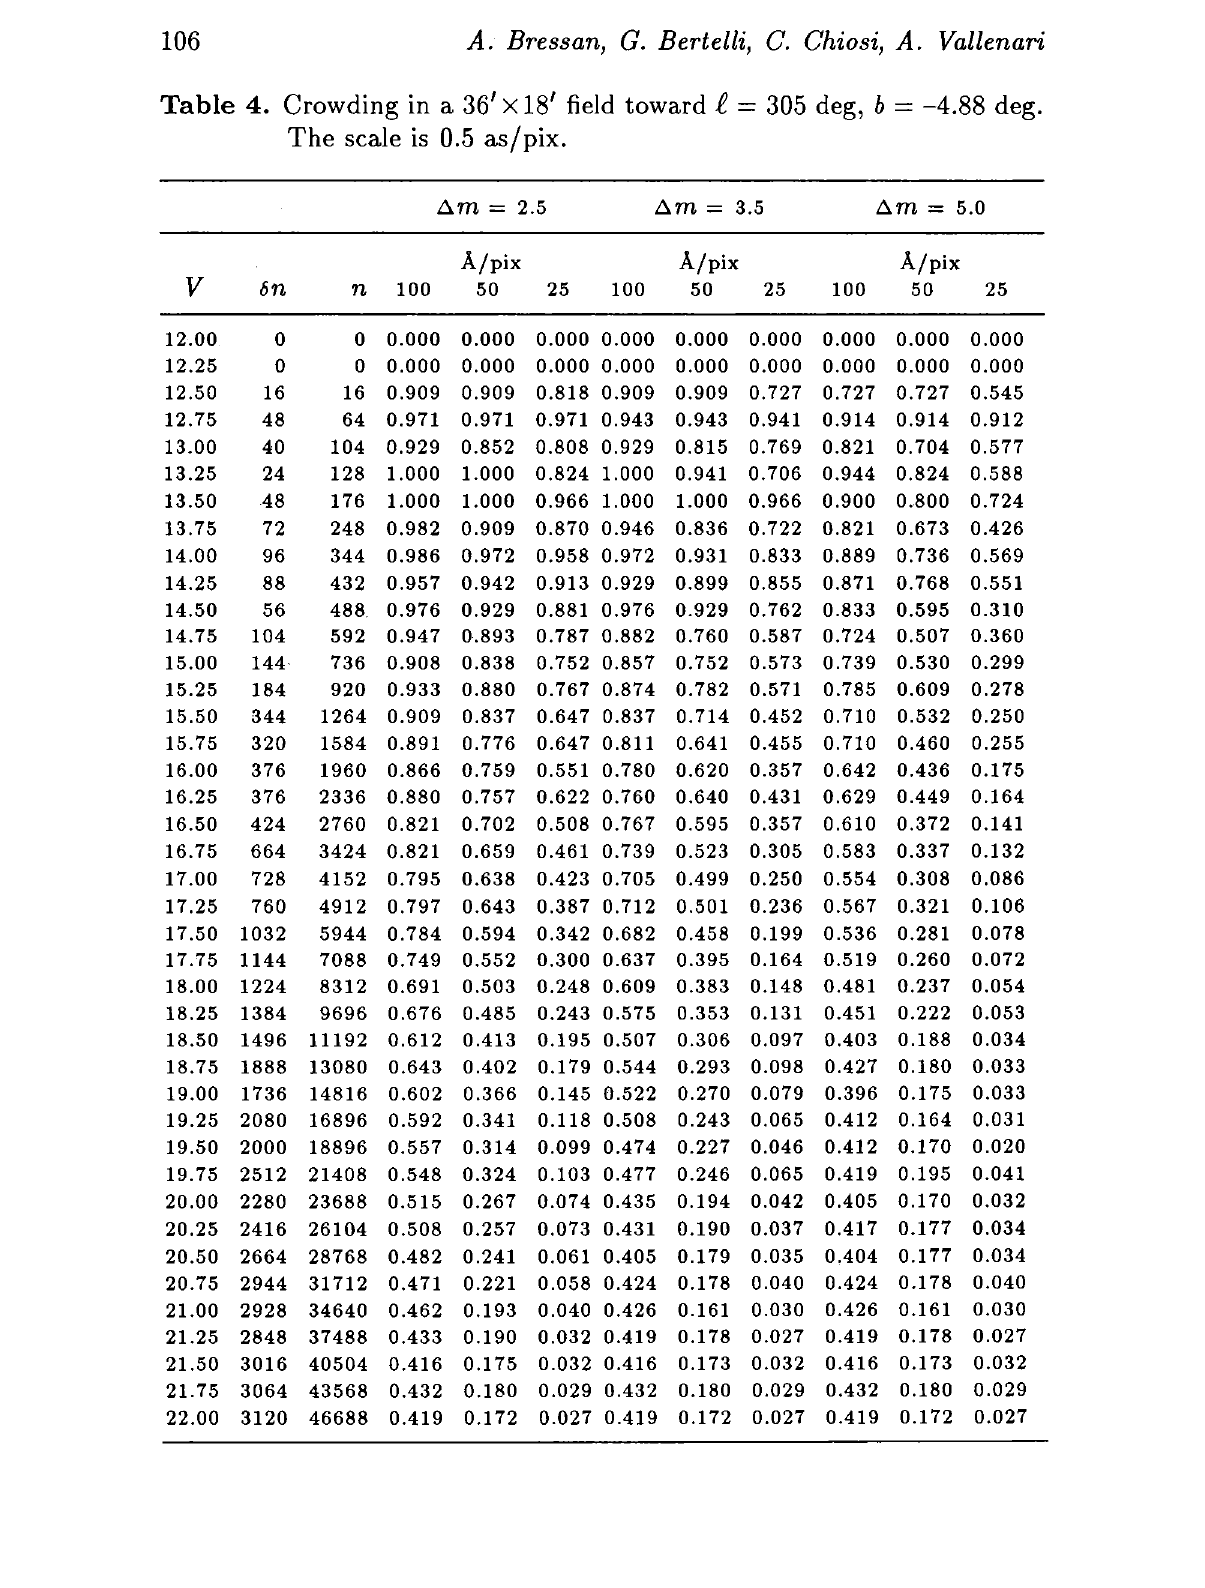
Table 4. Crowding in a 3 6 ' x l 8' field toward i = 305 deg, b = -4.88 deg. The scale is 0.5